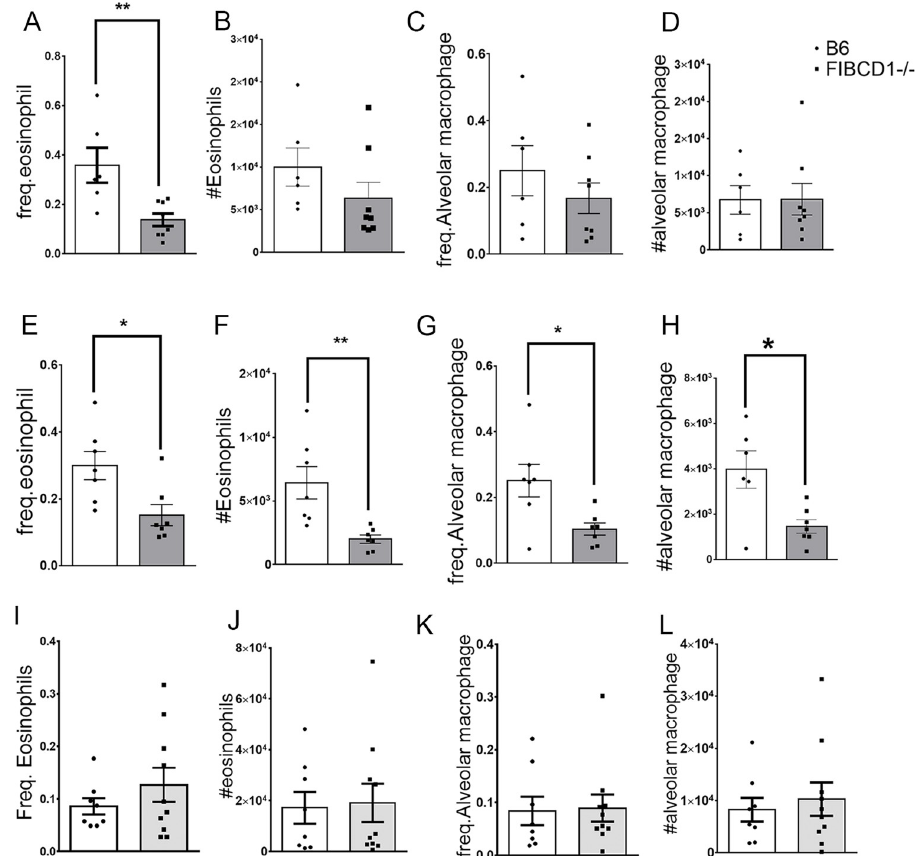
Fig 6. Differences in recruitment of inflammatory cells, in absence of gene, when challenged with different strains and dosage of Aspergillus conidia. Mice of both groups were challenged with either single high dose- 50x10^6 conidia- of two different strains of Aspergillus sp.-Af293 (A-D) and AfCEA-10 (E-H), or single low dose - 5x10^6- of high chitin-rich strain- Af5517 (I-L). BALF were analyzed for PMN cells recruitment. Representative flow plots depicting gating of CD45+Ly6G-SiglecF+CD11c-BALF eosinophils (A-B, C-D), CD45+Ly6G-SiglecF+CD11c + Alveolar macrophage (C-D, E-F). Data shown are a summary of two-three experiments. � p < 0.05, �� p <